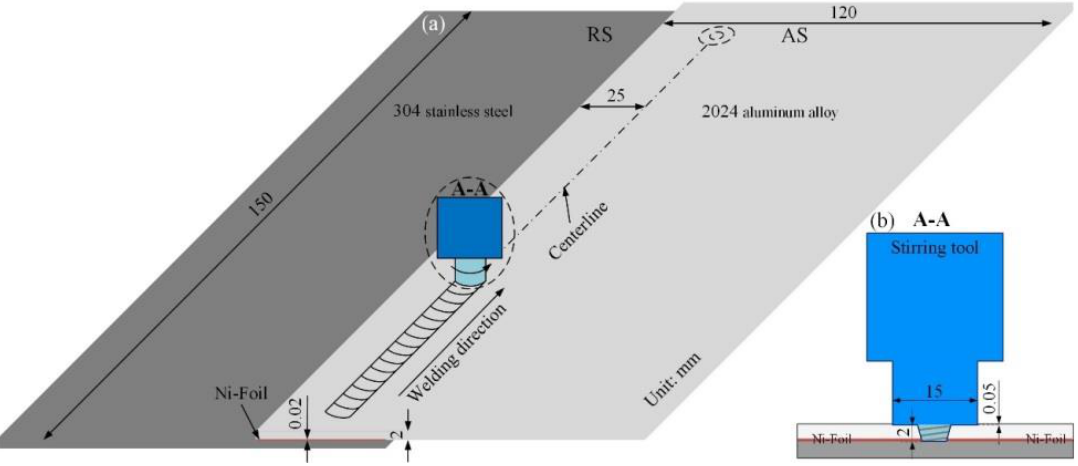
Figure 1. Schematic of FSLW: ( a ) welding process; ( b ) section view of A-A.